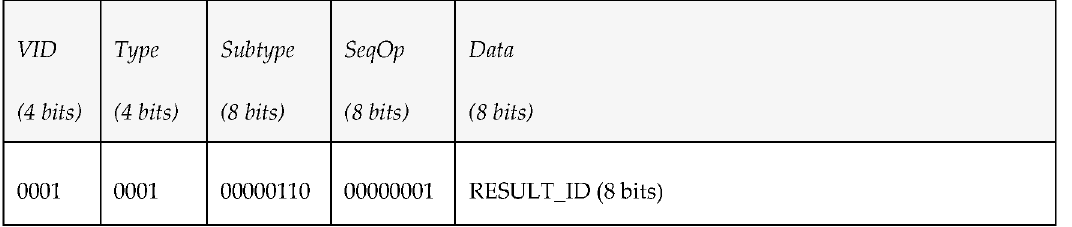
Figure 10. Appearance of the PDU used as an answer for the task reported.